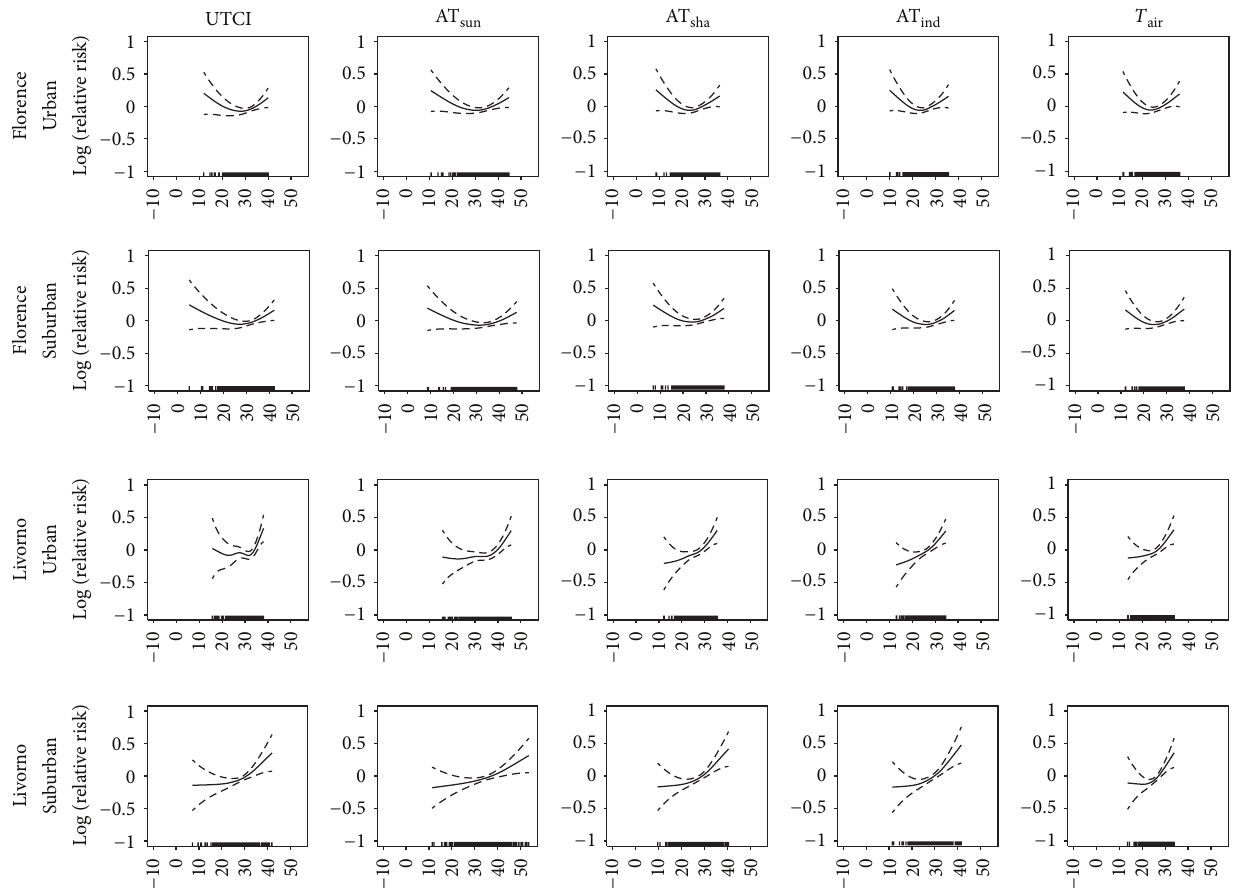
) ( ∘ C) and mortality of the very elderly (subjects ≥ 75 years of age) Figure 2: Relationships between daily maximum thermal predictors ( lag 0 - 1 in an inland city (Florence) and coastal-plain city (Livorno). Relationships estimated by using urban and suburban meteorological data for the period 2006–2008 (May–October). UTCI: Universal Thermal Climate Index; AT sun : apparent temperature assessed outdoors also taking the solar radiation contribution into account; AT sha : apparent temperature assessed outdoors in the shade; AT ind : apparent temperature assessed : environmental temperature. Analyses were controlled for air pollution concentrations, daylight hours, year, day of in indoor conditions; 𝑇 air the week, public holidays, and summer population